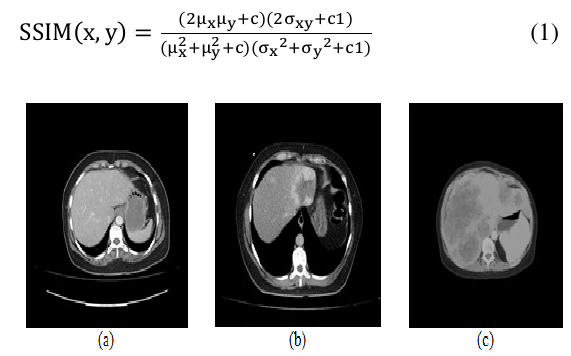
Fig. 2: Abdominal CT Images (a) Normal Liver (b) Liver with Benign Tumor [27] (c) Liver with Malignant